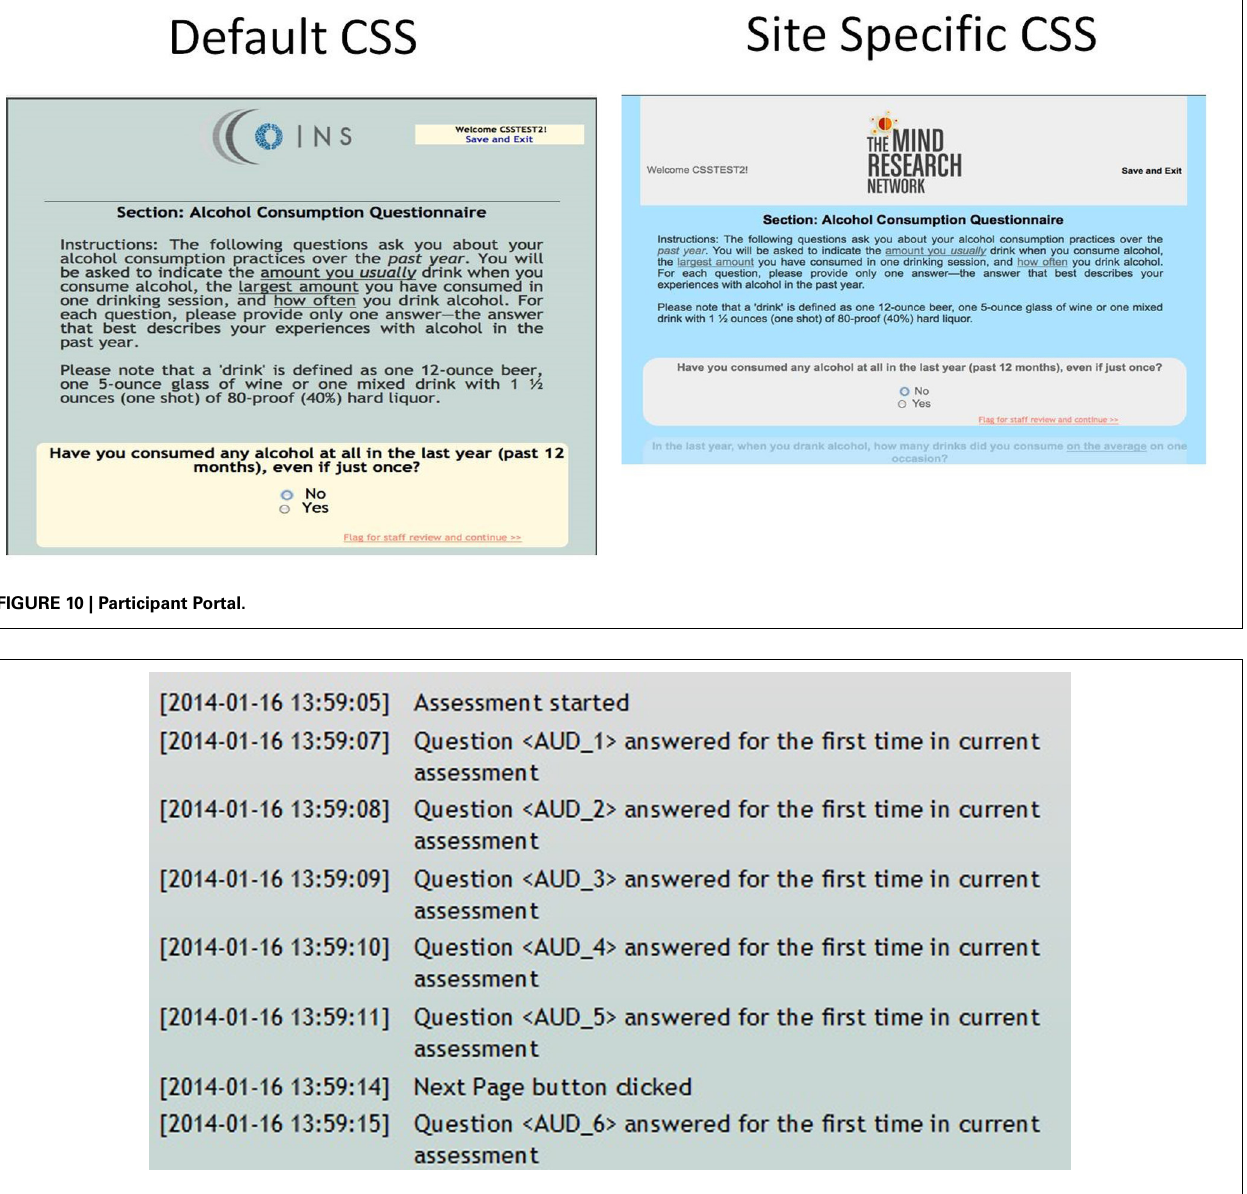
FIGURE 11 | Self assessment time